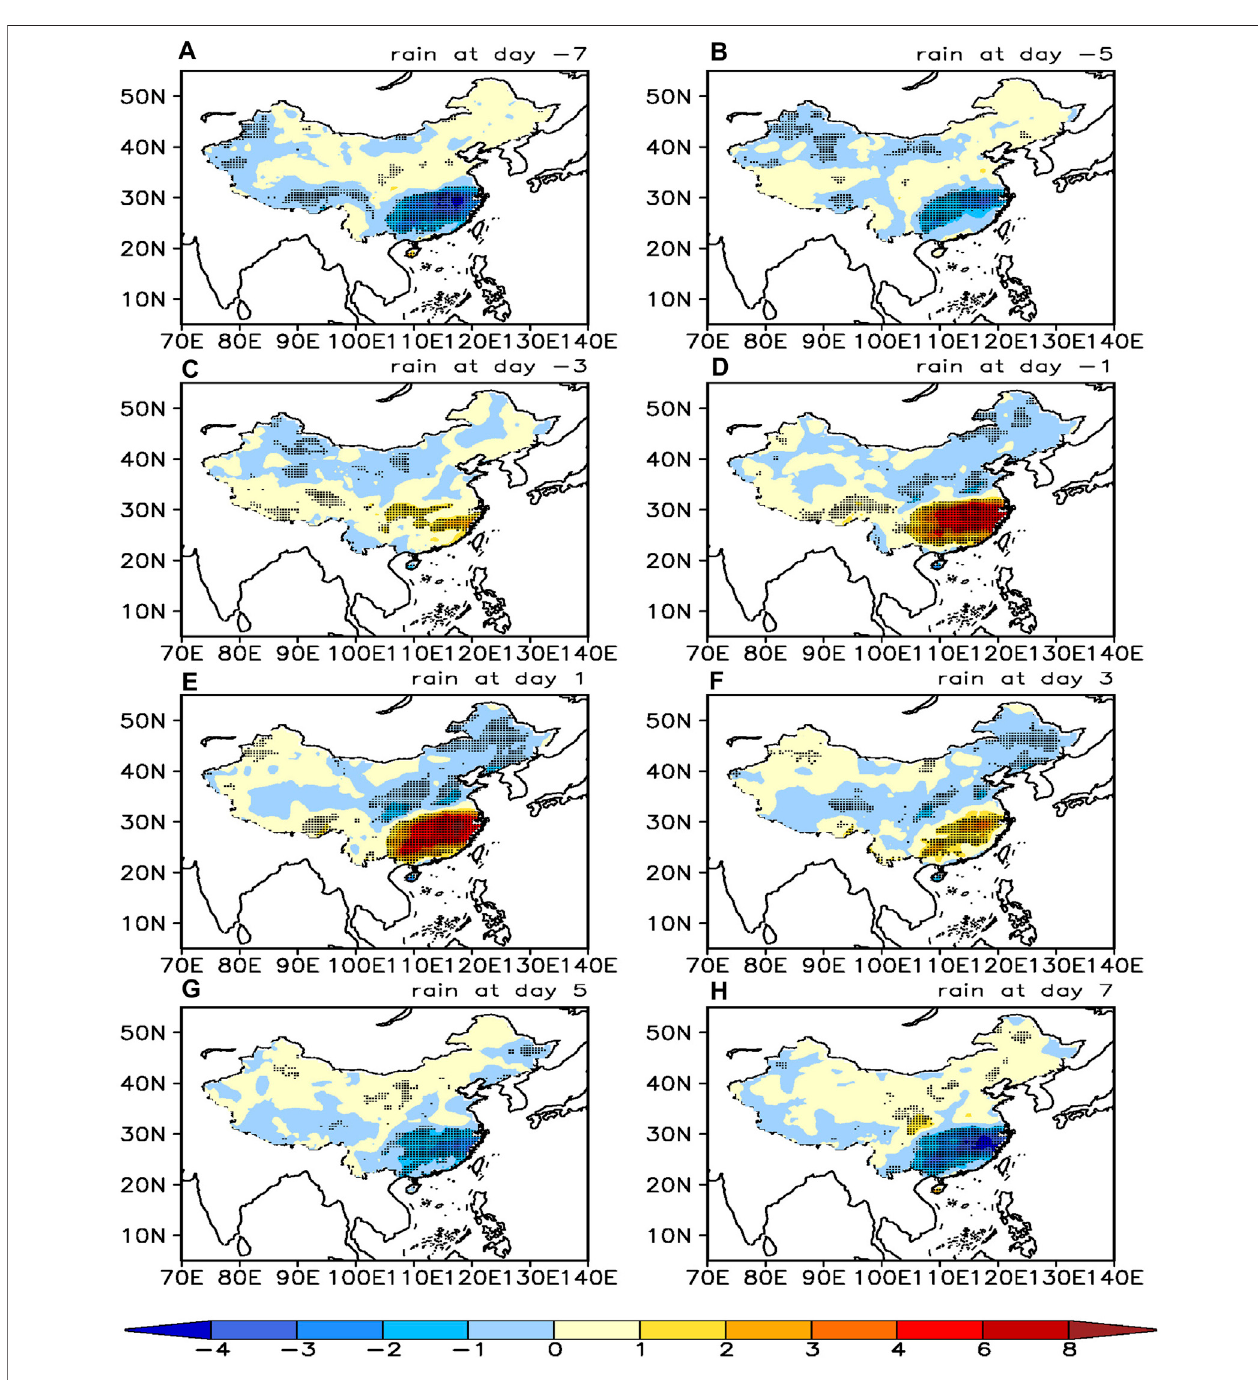
FIGURE4 | Composite distribution of 10-to 30-day fi ltered precipitation during the rainfall QBWO events (unit:mm/d);the dotted area indicates that ithas passed the 95% con fi dence test. (A – H) represent day -7 to day 7, with 2-day interval.